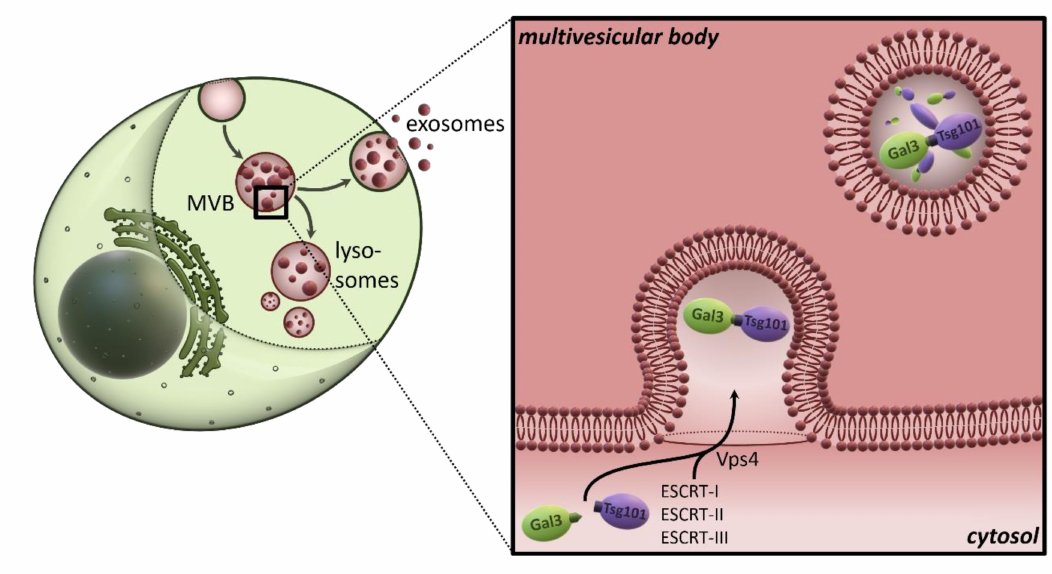
Figure 2. Exosomal secretion of galectin-3. A conserved P(S / T) AP motif in the amino-terminal region of galectin-3 directly interacts with the endosomal sorting complex required for transport (ESCRT)–component Tsg101. This interaction recruits galectin-3 into newly formed intraluminal vesicles (ILVs) of the multivesicular body (MVB). ILVs are sorted to lysosomes for degradation or released as exosomes into the outer